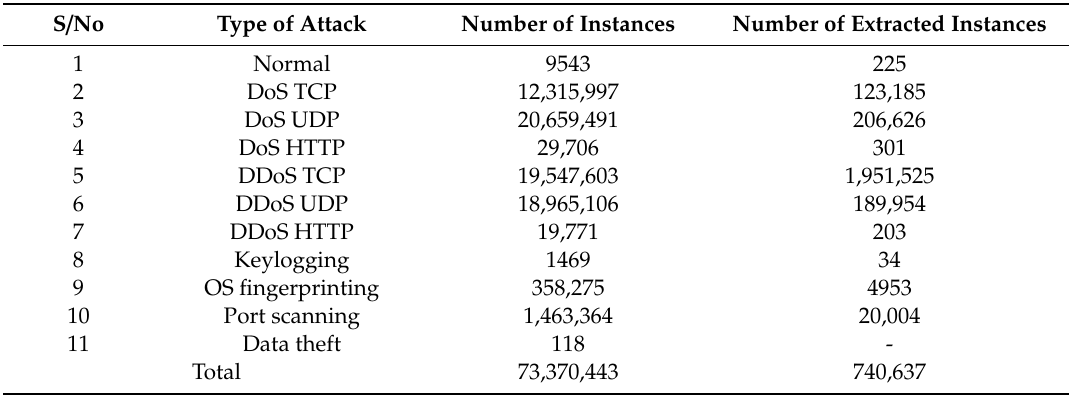
Table 3. Summary of original and extracted instances.